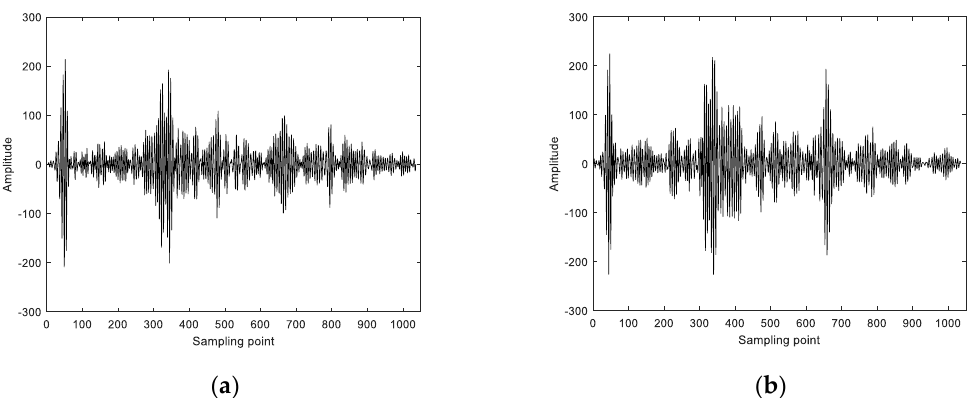
Figure 4. Time-domain samples of experimental ultrasonic scattered echo: ( a ) non-denatured tissue; ( b ) denatured tissue.